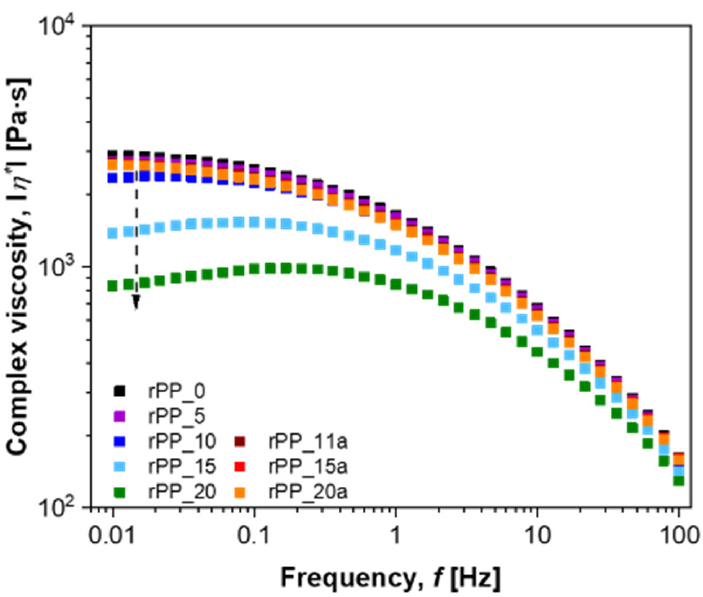
Figure 7. Dynamic rheological behavior of virgin PP, recycled PP without and with additive, complex viscosity, measured at 190 °C.